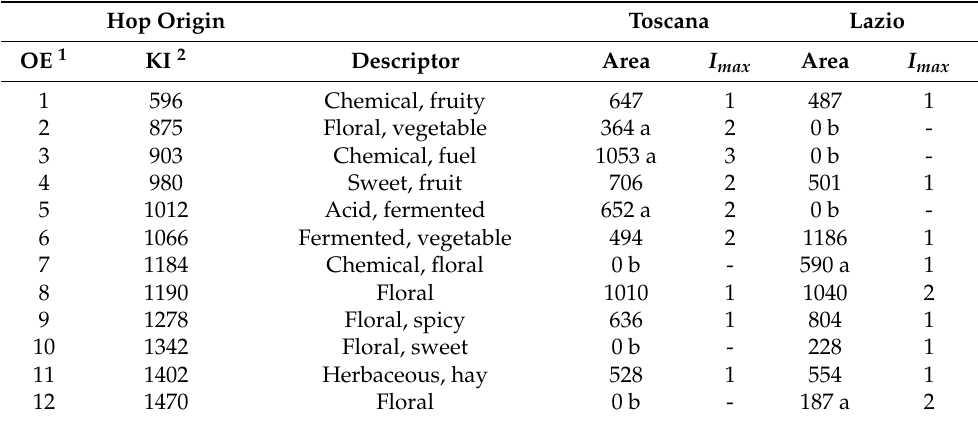
Table 5. GC-O analysis of beer samples: odour descriptors, average OE areas and maximum odour intensities (median, I max ).